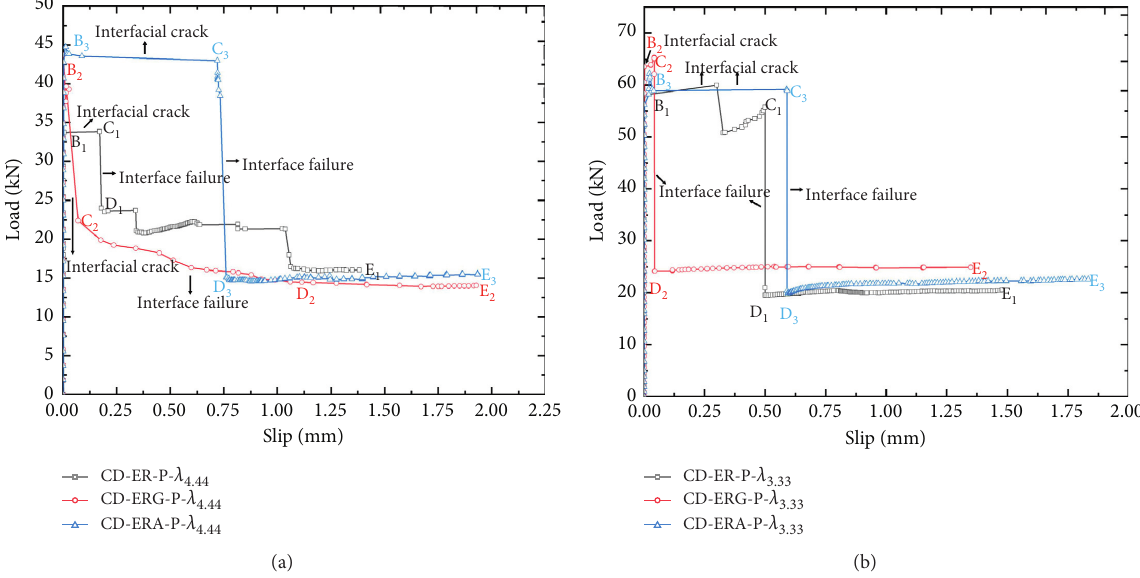
Figure 8: Load-slip curves of specimens. (a) Ratio of shear span to depth ( λ 1 � 4.44). (b) Ratio of shear span to depth ( λ 2 � 3.33).